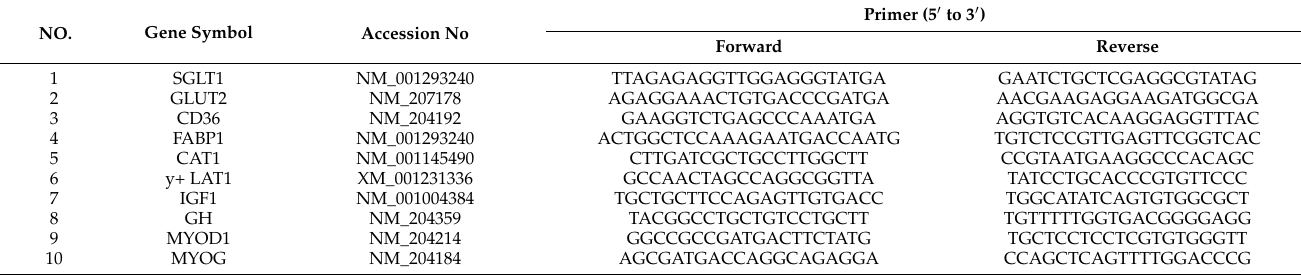
Table 2. Primers sequences used in the real-time RT-PCR